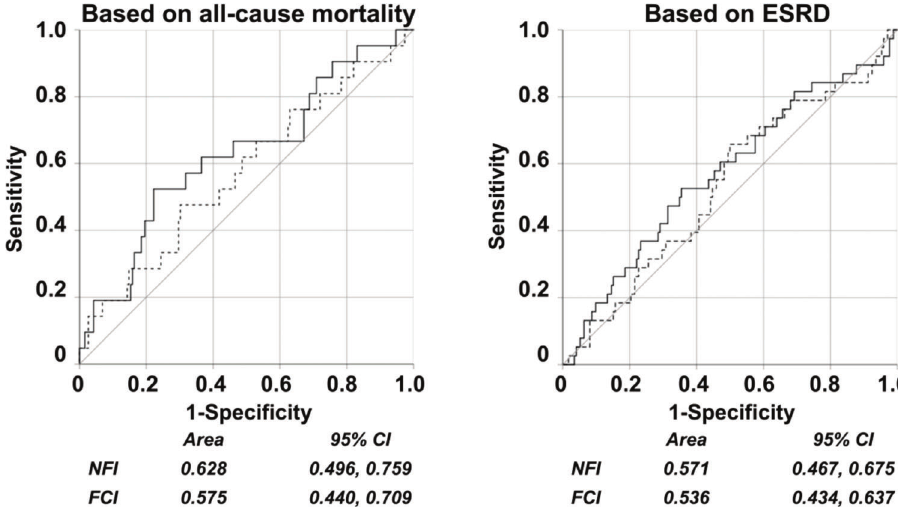
Supplementary Figure 1 - Comparison of the areas under the curve between NFI and FCI in the ROC curve analysis based on all-cause mortality and ESRD occurrence. NFI: novel fibrosis index; FCI: fibrosis cirrhosis index; ROC: Receiver Operating Characteristic; ESRD: end- stage renal